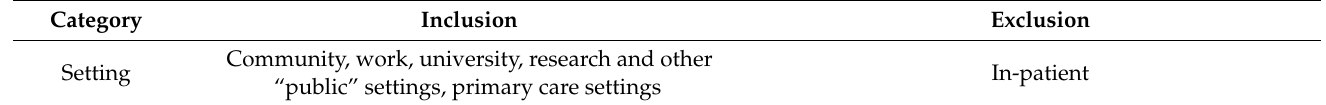
Table 1. Eligibility criteria for systematic review examining the effect of nutrition and physical activity interventions provided by nutrition and exercise